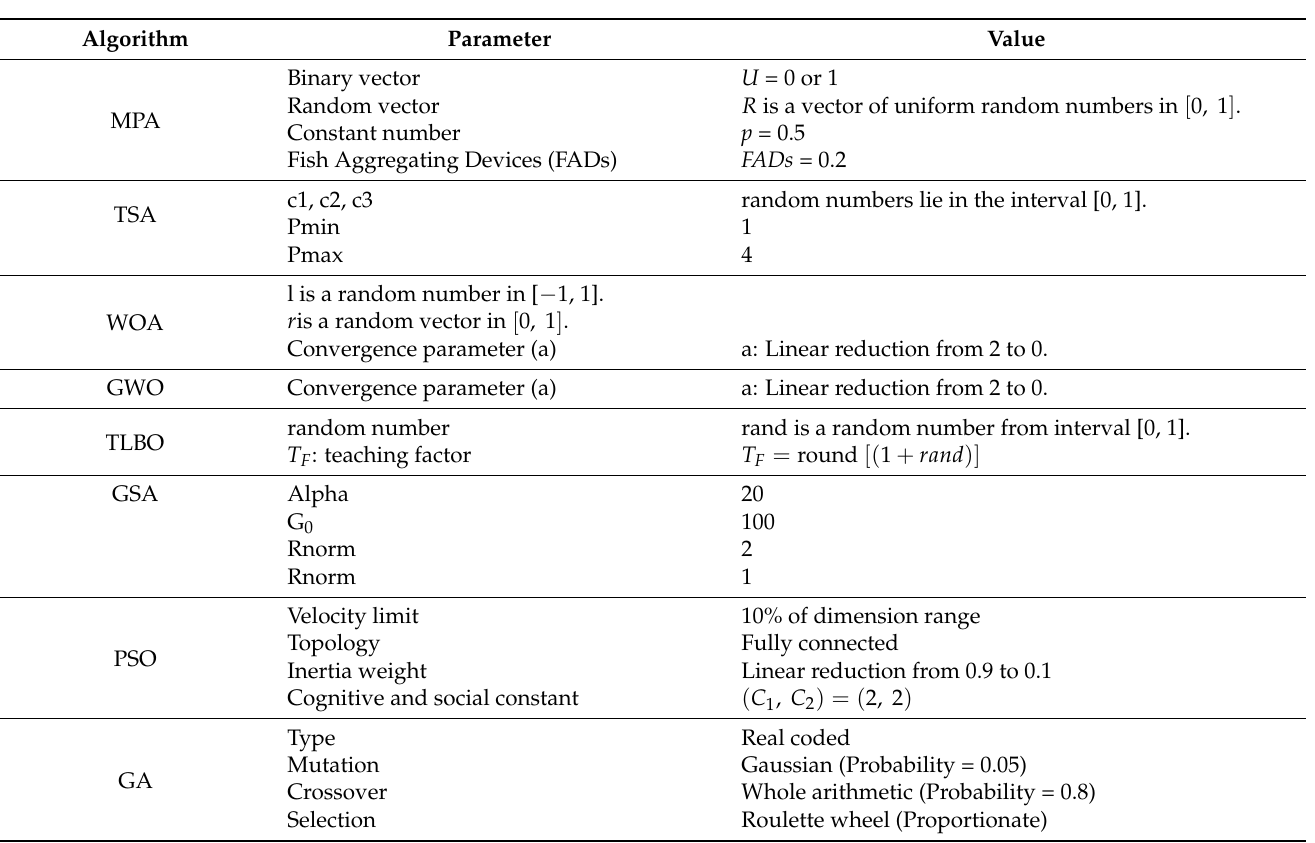
Table 1. Parameter values for the compared